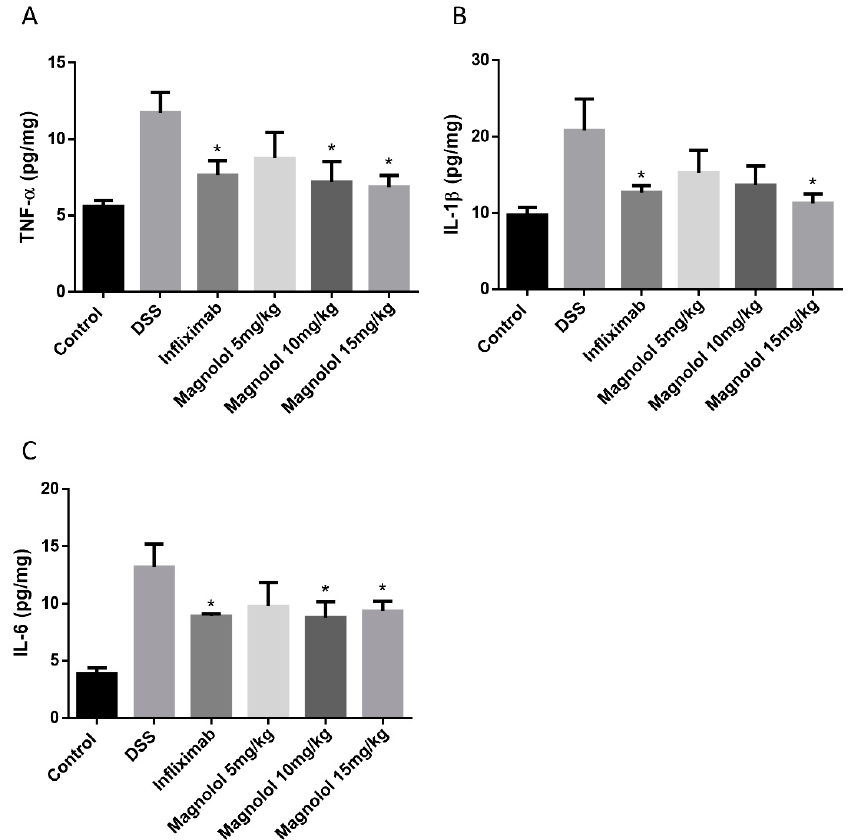
Figure 3. Medium and/or high dosages of magnolol significantly attenuated DSS-induced high levels of proinflammatory cytokines TNF- α ( A ), IL-1 β ( B ) and IL-6 ( C ) in the colonic tissues. The value in the plot was expressed as means ± SEM, and statistically significant was marked by asterisk (* p < 0.05).